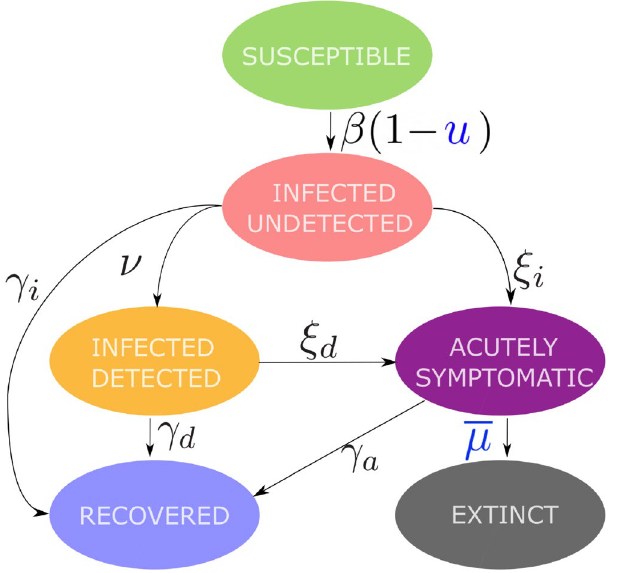
Figure 1. The controlled SIDARE model. Schematic representation of the controlled SIDARE model, used to describe the evolution of the COVID-19 pandemic. The model splits the population into Susceptible, Infected undetected, infected Detected, Acutely symptomatic—threatened, Recovered and deceased—Extinct. Model parameters β , ξ i , ξ d , ν , γ i , γ d and γ a describe the transition rates between the states. The effect of government interventions is described by u which limits the rate of infection. The rate at which the acutely symptomatic population deceases is described by µ , which depends on the healthcare system